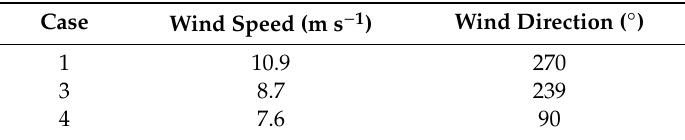
Figure 4. Bolund Hill terrain and measurement locations. Axes labels are in meters, and north is toward the top of the figure. Table 4. Bolund Hill cases investigated.